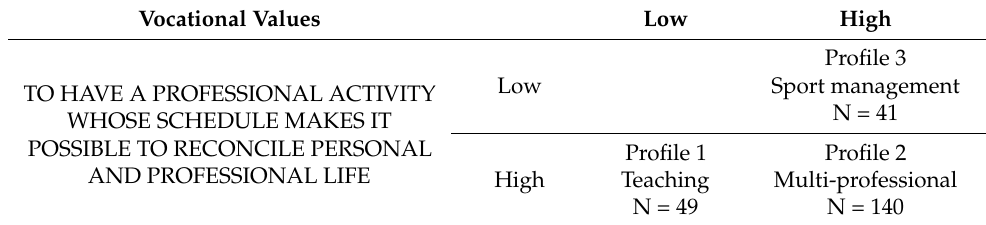
Table 2. Conceptualization of the groups according to the resulting combination of their two preferred vocational